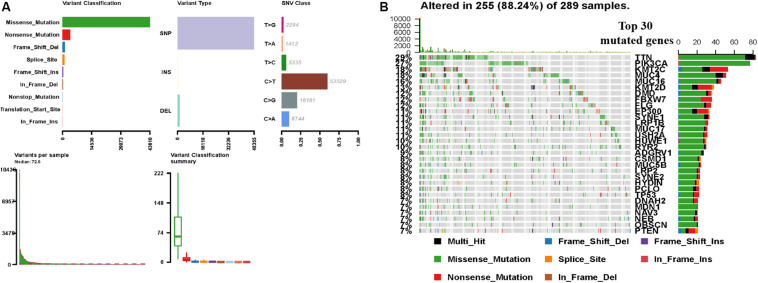
TCGA CCC mutation cohort (n = 289). (A) Overview of TGCA CCC cohort mutations, including variant classification, variant type, class of SNV, variants in each sample, and variant classification summary. (B) Waterfall plot of the top genes commonly mutated in the TCGA CCC cohort, in which the row represents the gene that affects the most frequent mutation in TCGA and the list represents the sample. Different types of genomic changes are represented by different colors. CCC, cervical cell carcinoma. SNV, somatic mutation.